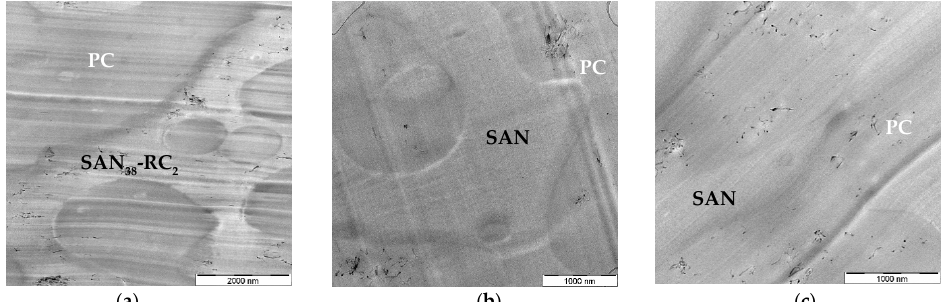
Figure 2. TEM images of PC 60 /SAN 40 - x -RC x blends filled with NCg-7000-1 ( a , b ) and NCg-7000-2 ( c ): ( a ) PC 60 /SAN 38 -RC 2 blends showing NCg-7000-1 (0.5 wt. %) in SAN-RC; and ( b ) in PC 60 /SAN 40 blends NCg-7000-1 and ( c ) in PC 60 /SAN 40 blends NCg-7000-2 (0.5 wt. %) stay in PC.